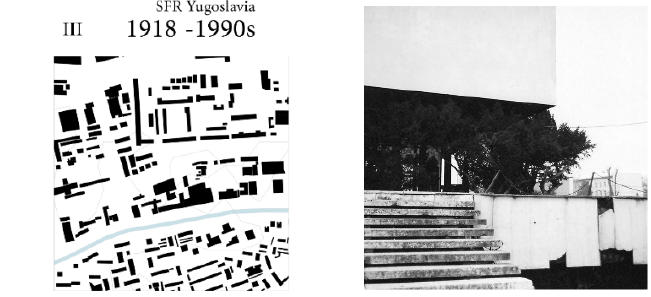
Figure 5: The modernist part of the city in plan and the History Museum of Bosnia & Herzegovina designed by Boris Magaš, in